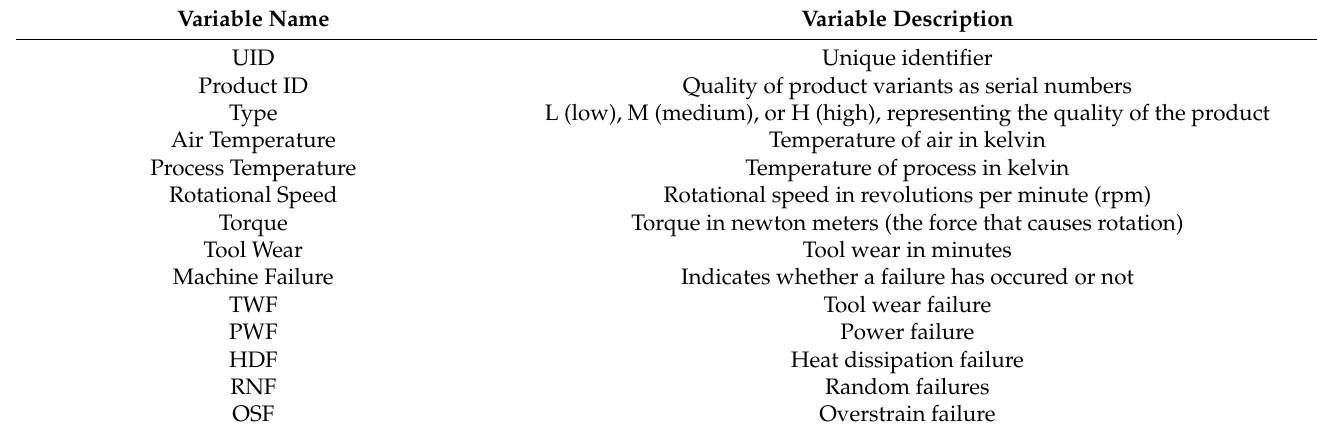
Table 2. Dataset variables.